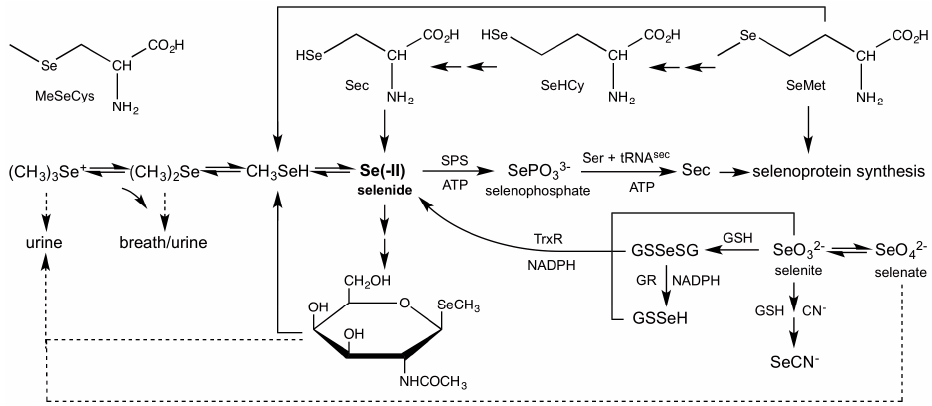
Figure 3. Metabolic pathways for dietary selenium compounds.